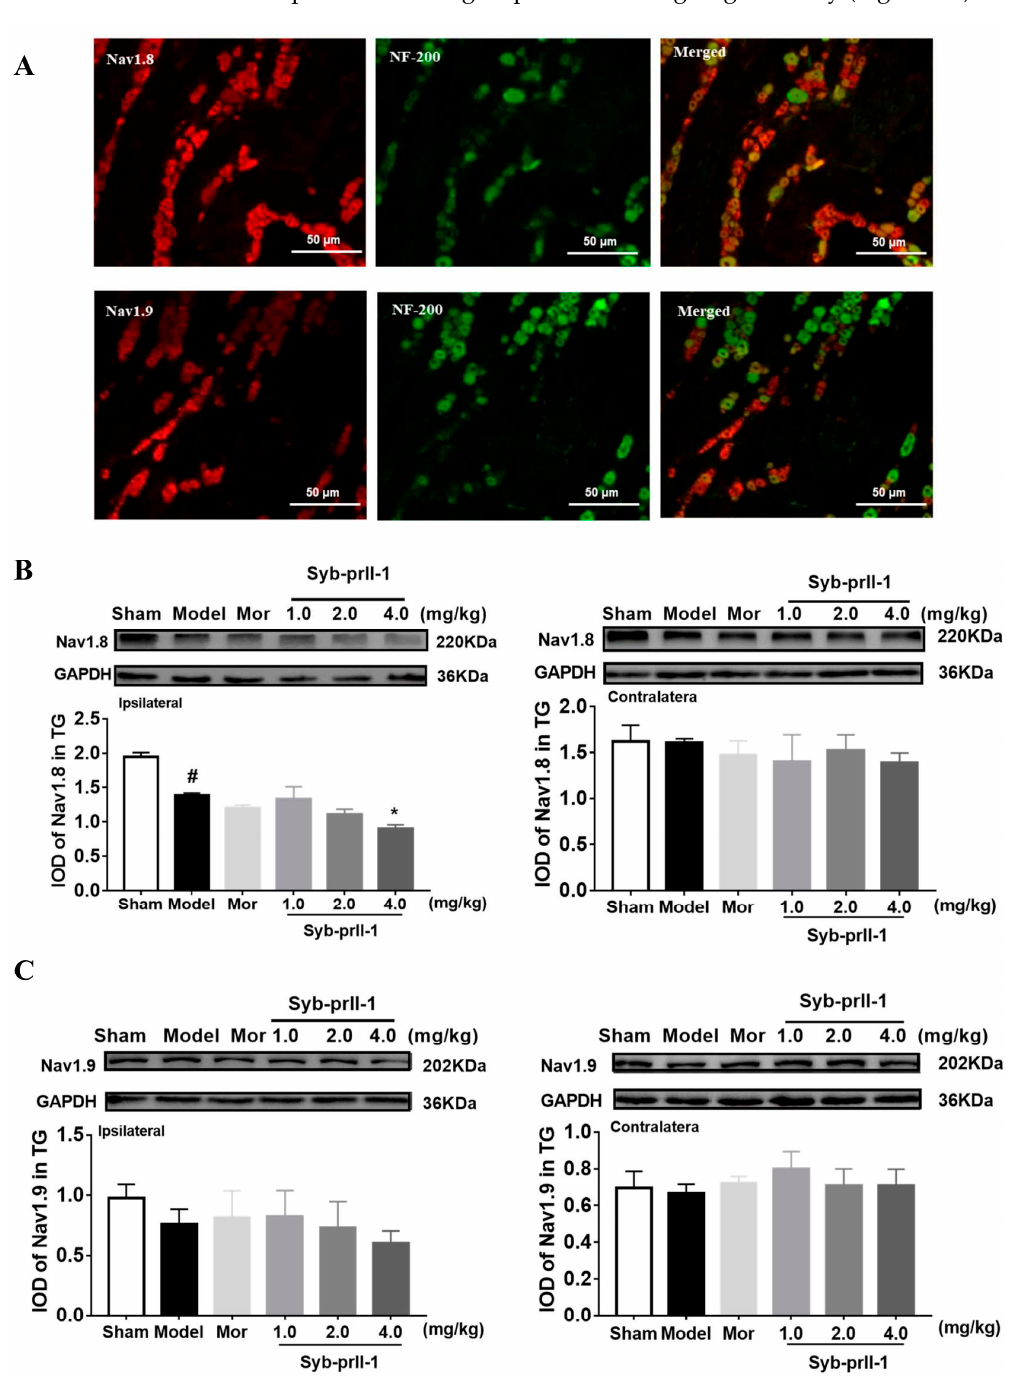
protein was significantly decreased in the 4.0 mg/kg Syb ‐ prII ‐ 1 group (Figure 3B). The was significantly decreased in the 4.0 mg/kg Syb-prII-1 group (Figure 3B). The expression expression of Nav1.9 protein in each group did not change significantly (Figure 3C). of Nav1.9 protein in each group did not change significantly (Figure 3C).